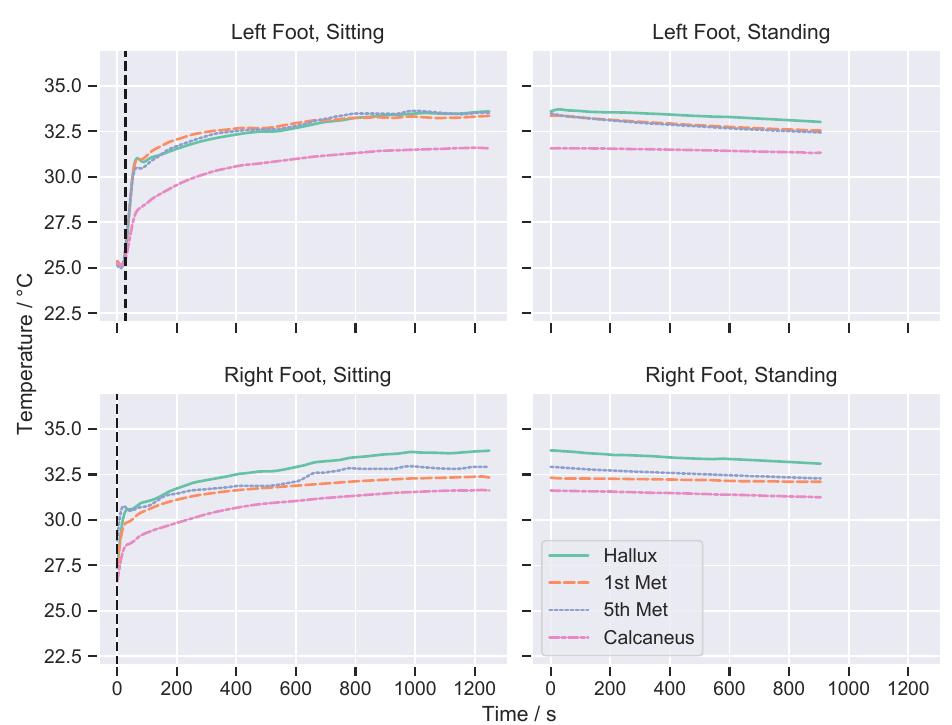
Figure 6. Example raw data from a single participant, showing data for both feet in the sitting and standing stages. Vertical dashed lines indicate the point when the participant put the shoes on. Note that the standing period immediately follows the sitting period (without a break) and therefore the data is continuous between the sitting and standing panels in this